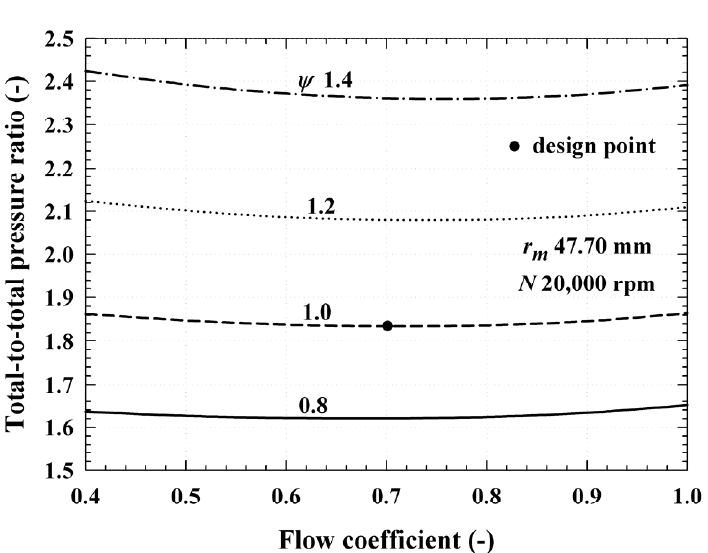
Figure 6. Total-to-total pressure ratio ( PR ) of the turbine when the flow coefficient ( 𝜑 ) ranges from 0.4 to 1.0 and loading coefficient ( 𝜓 ) ranges from 0.8 to 1.4.